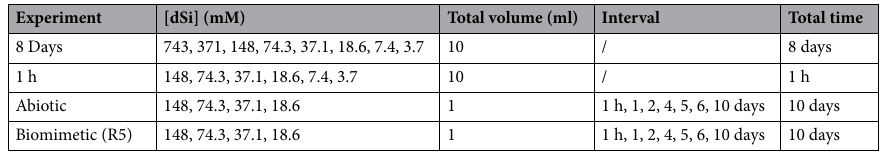
Table 2. Experimental